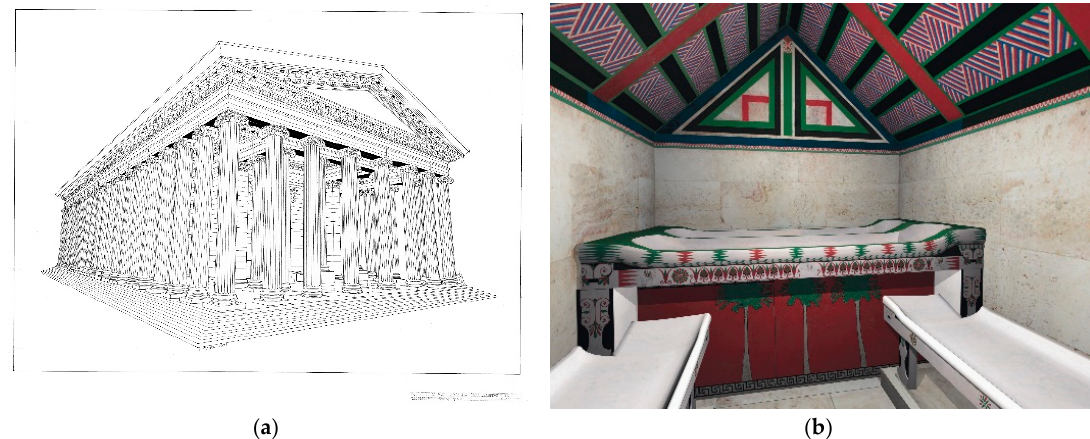
Figure 2. Illustrations of Sardis. ( a ) Reconstruction of fully restored Roman phase of the Temple of Artemis, view from southeast, by Fikret Yegül. Image Courtesy: The Archaeological Exploration of Sardis/President and Fellows of Harvard College (used by permission); ( b ) Reconstruction of tumulus chamber at Lale Tepe (Stinson). Image Courtesy: The Archaeological Exploration of Sardis/President and Fellows of Harvard College. Appeared in (Stinson 2003, p. 141; used by permission).